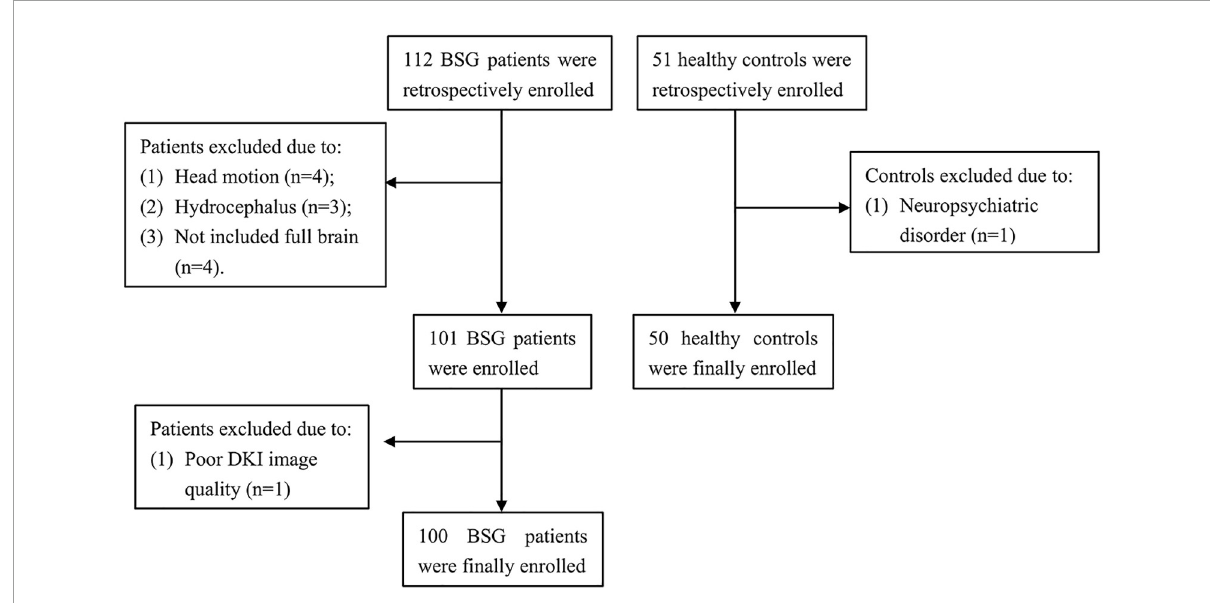
FIGURE1 Flowchart of the study. BSG, brainstem glioma.